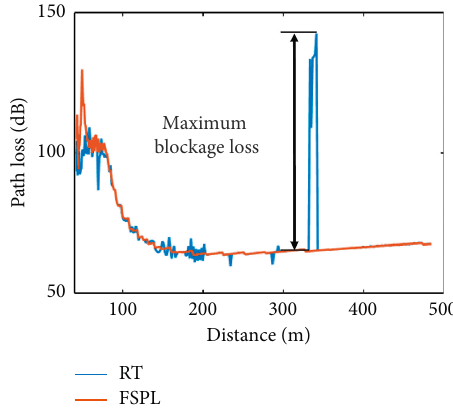
Figure 16: An example of blockage loss, RT, raytracing; FSPL, free space path loss. Table 10: Extracted parameters for the blockage